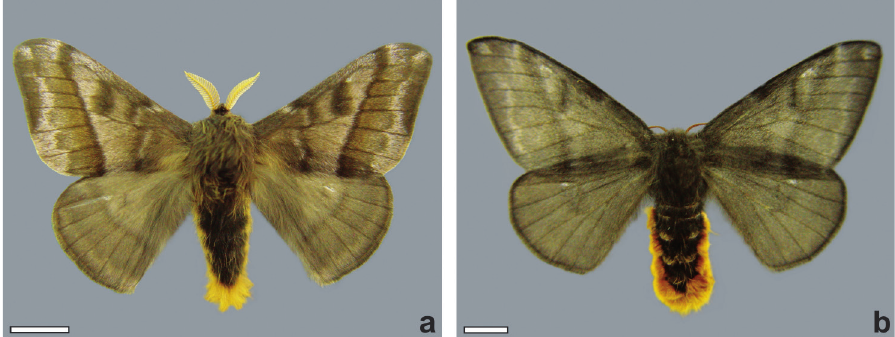
Figure 1 - Hylesia oratex. (a) male; (b) female (scale = 5 mm,